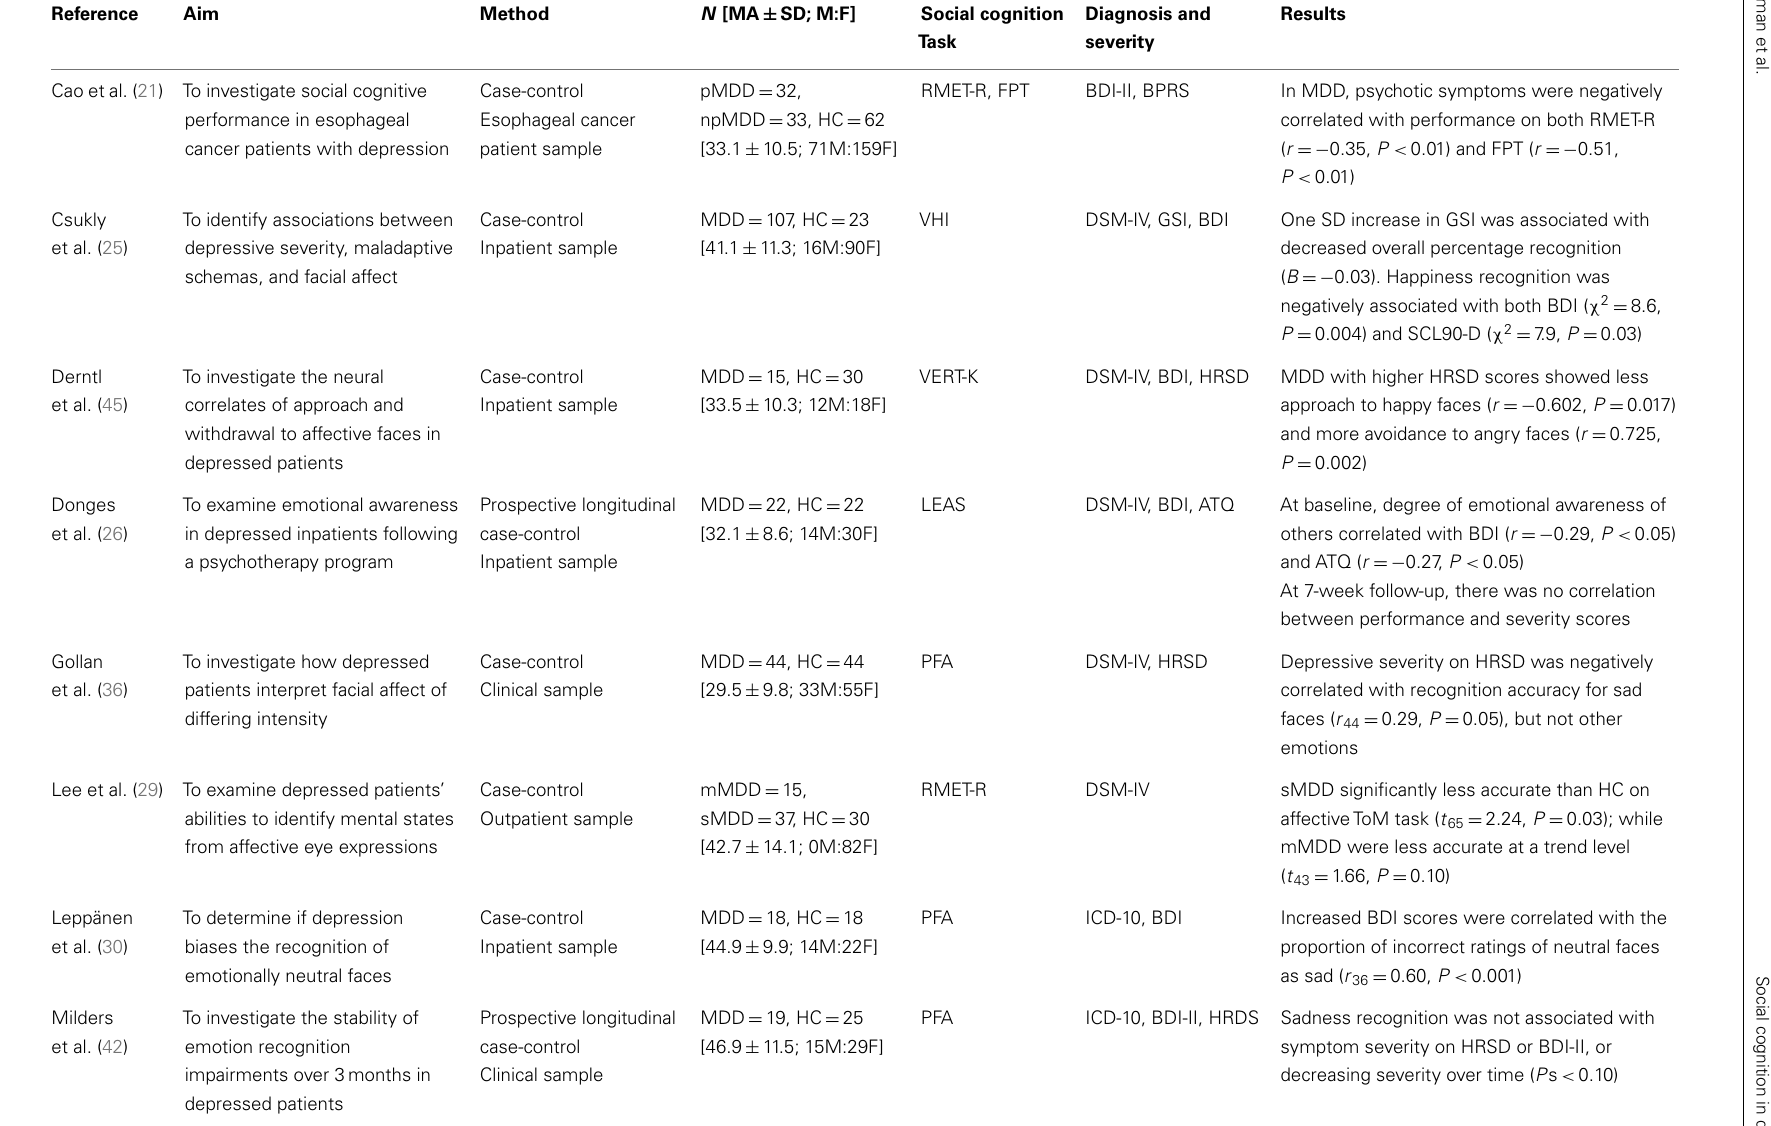
Table 3 |Association between severity of depressive symptoms and social cognitive performance